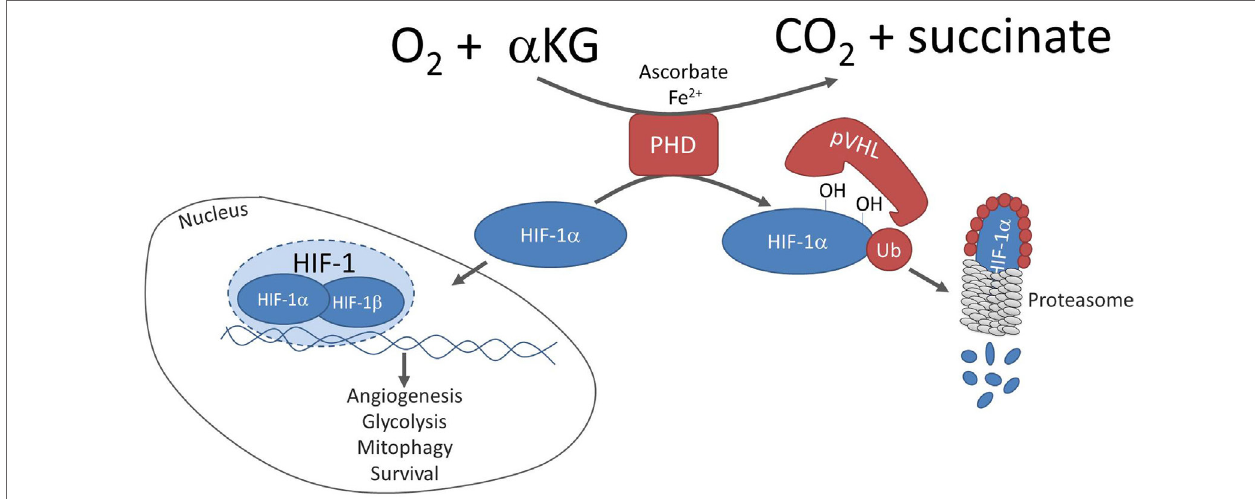
FiGURe 1 | Canonical regulation of HIF-1 α stability. In normoxia, prolyl hydroxylases (PHDs) hydroxylate hypoxia-inducible factor 1 alpha (HIF-1 α ) on two proline residues, triggering pVHL-mediated ubiquitination and proteasomal degradation of hydroxylated HIF-1 α . The hydroxylation reaction is coupled to conversion of α KG to succinate and requires co-factors ascorbate and ferrous iron. In hypoxia, hydroxylation is inhibited and HIF-1 α dimerizes with constitutively expressed HIF-1 β , creating an active HIF-1 complex, which transcribes genes promoting angiogenesis, glycolytic metabolism, mitophagy, and